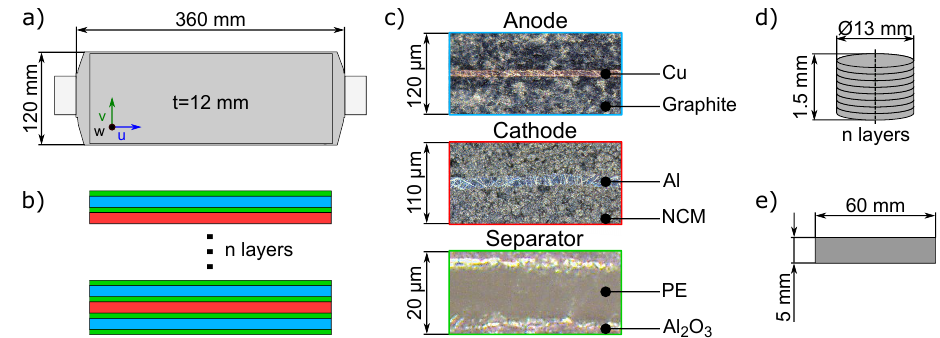
Figure 1. Overview of the used NCM lithium-ion pouch cell and specimen geometries for the component tests: ( a ) cell geometry; ( b ) layer structure: anode (blue), cathode (red), and separator (green); ( c ) microscopic analyses, ( d ) test stack of compression test; ( e ) tensile test